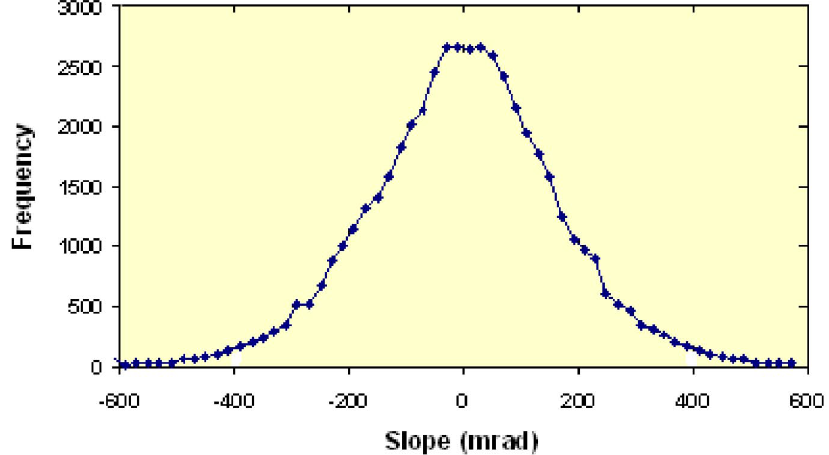
FIG. 9. (Color) Surface slope distribution for the RHIC beam pipe